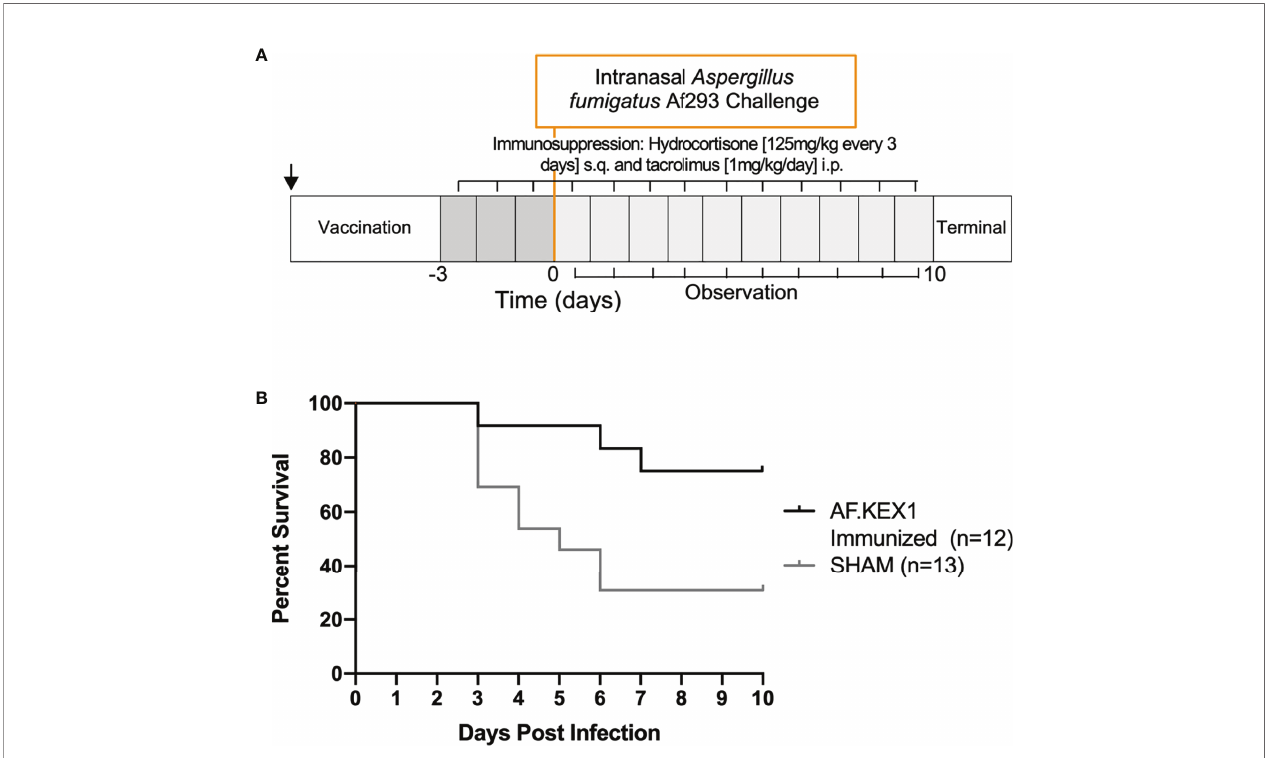
FIGURE 3 | Invasive pulmonary aspergillosis in a tacrolimus/hydrocortisone immunosuppression model. (A) Challenge study design. (B) Survival curve of AF.KEX1- immunized animals, compared with SHAM. AF.KEX1-immunized animals were signi fi cantly protected from developing aspergillosis while immunosuppressed with tacrolimus and hydrocortisone, compared with sham-immunized controls ( p = .0183, by Mantel-Cox test). Immunization is indicated by